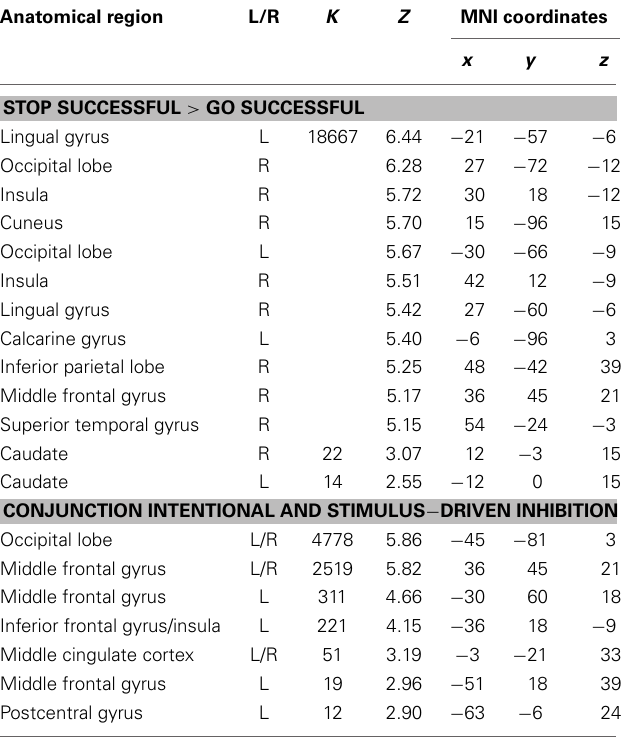
Table 4 | Brain regions revealed by whole brain contrasts taking together intentional and stimulus-driven inhibition (all FDR corrected, p < 0 . 05, > 10